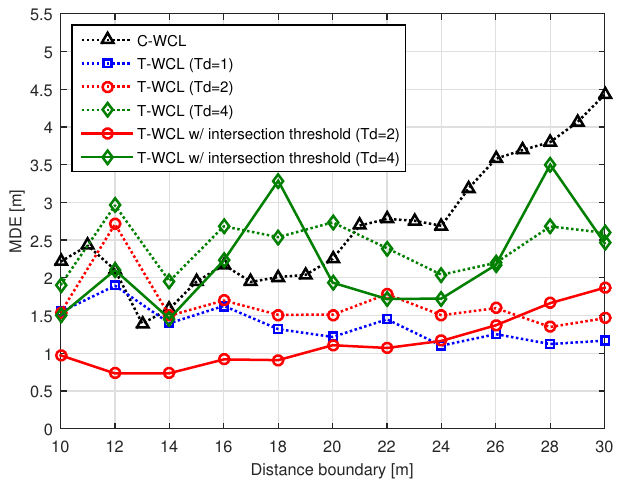
Figure 5. MDE performance according to the distance boundary with the test node deployment